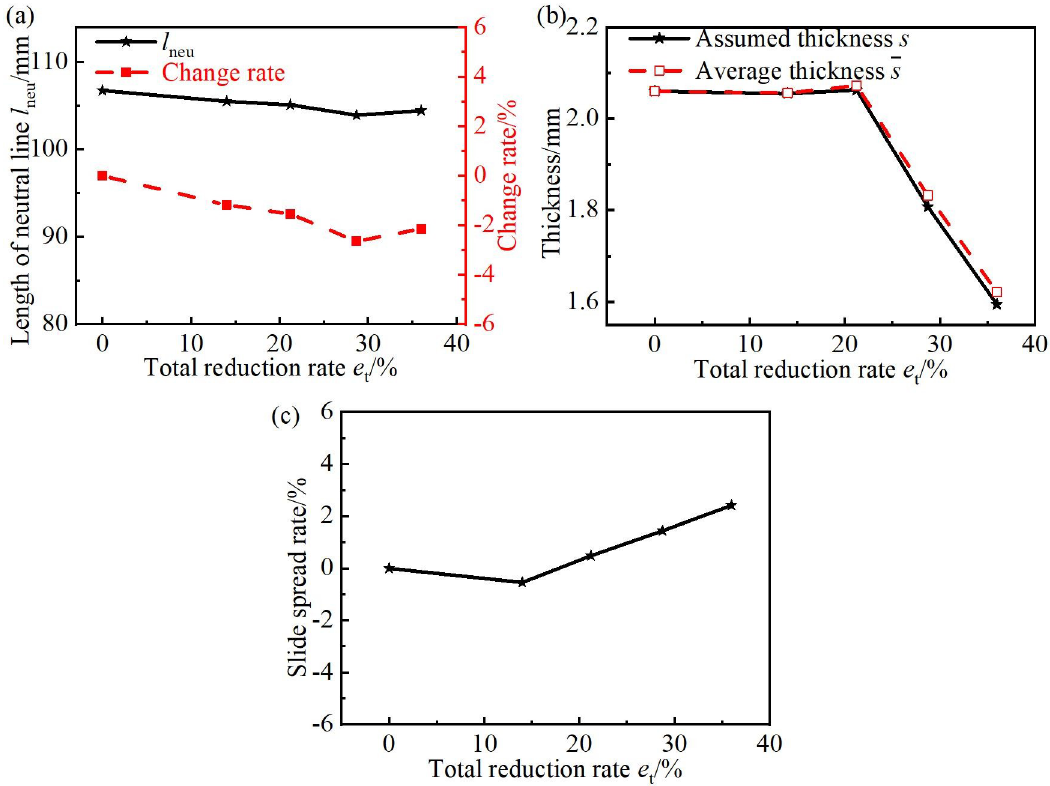
Fig 9. Validation of hypotheses on thickness, neutral line and slide spread rate. (a) Length of the neutral line, (b) comparison of the assumed thickness and average thickness, and (c) slide spread rate.